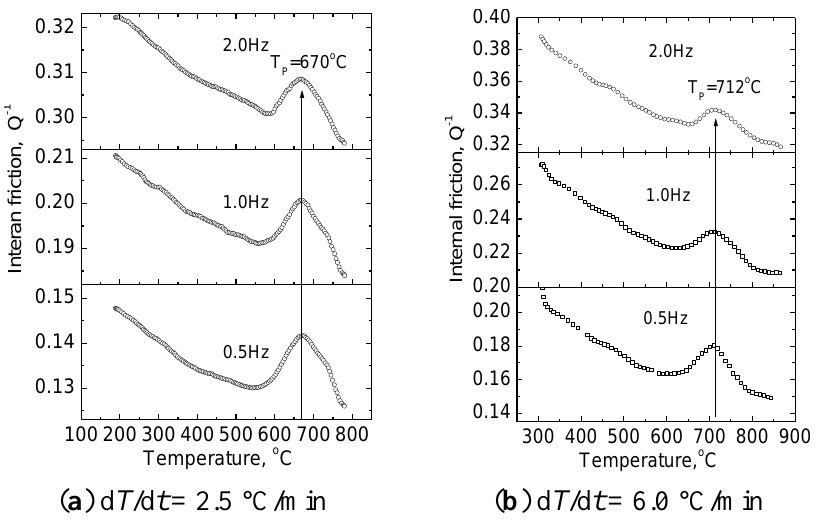
Figure 1. Internal friction behavior of the melt Pb-Sn61.9.